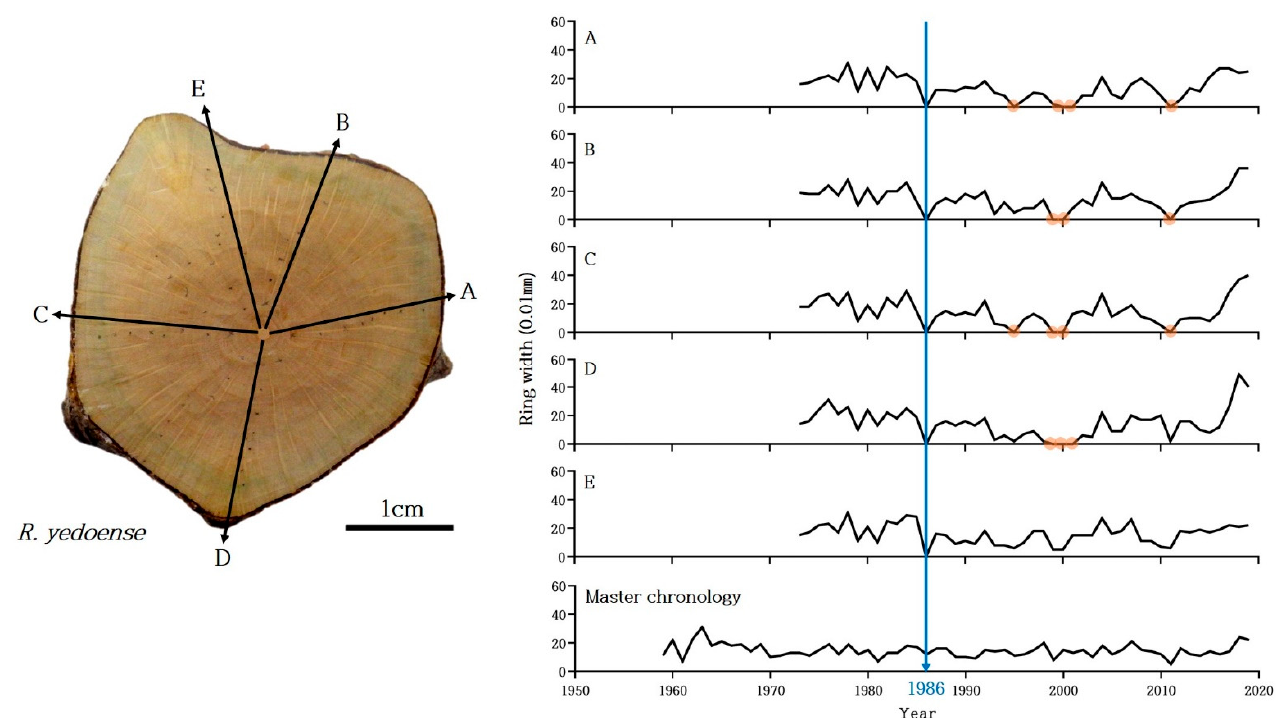
Figure 3. Example of missing (blue line) and discontinuous rings (orange dots) based on synchronization test between individual time series established along each direction (A, B, C, D, and E) on a disk ( Rhododendron yedoense ) and the corresponding master chronology.